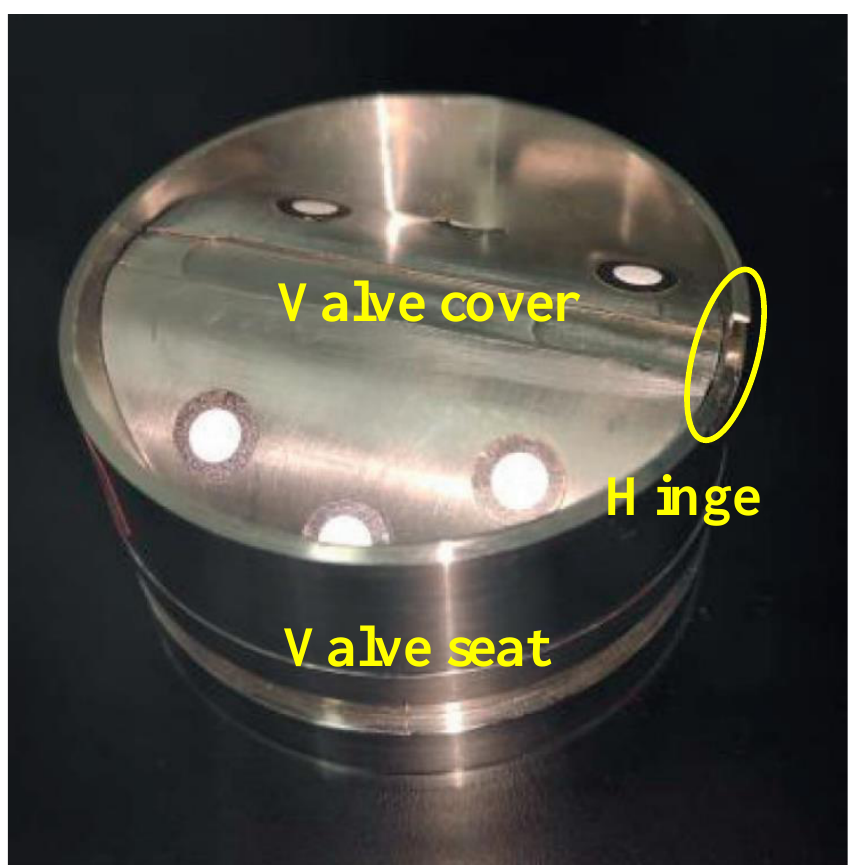
Figure 1. Physical diagram of pressure-holding controller based on principle of geometric intersection of cylinder and cone.